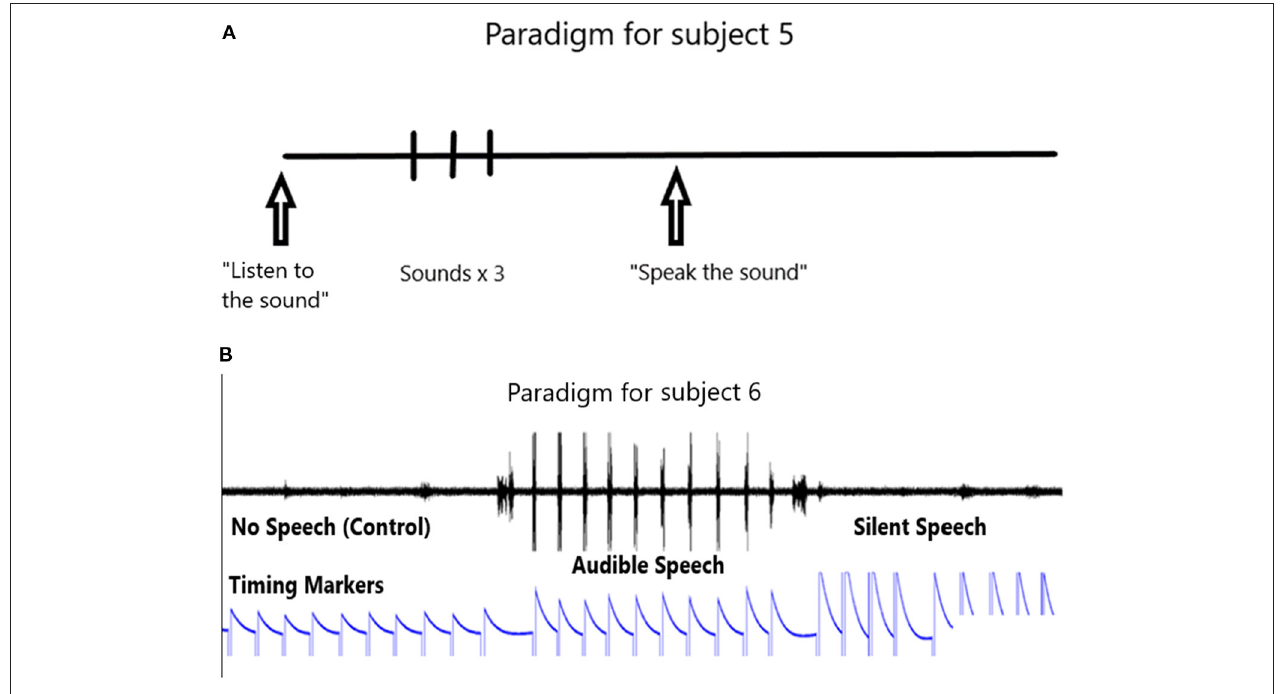
FIGURE 3 | (A) Paradigm for participant 5. (B) Paradigm for participant